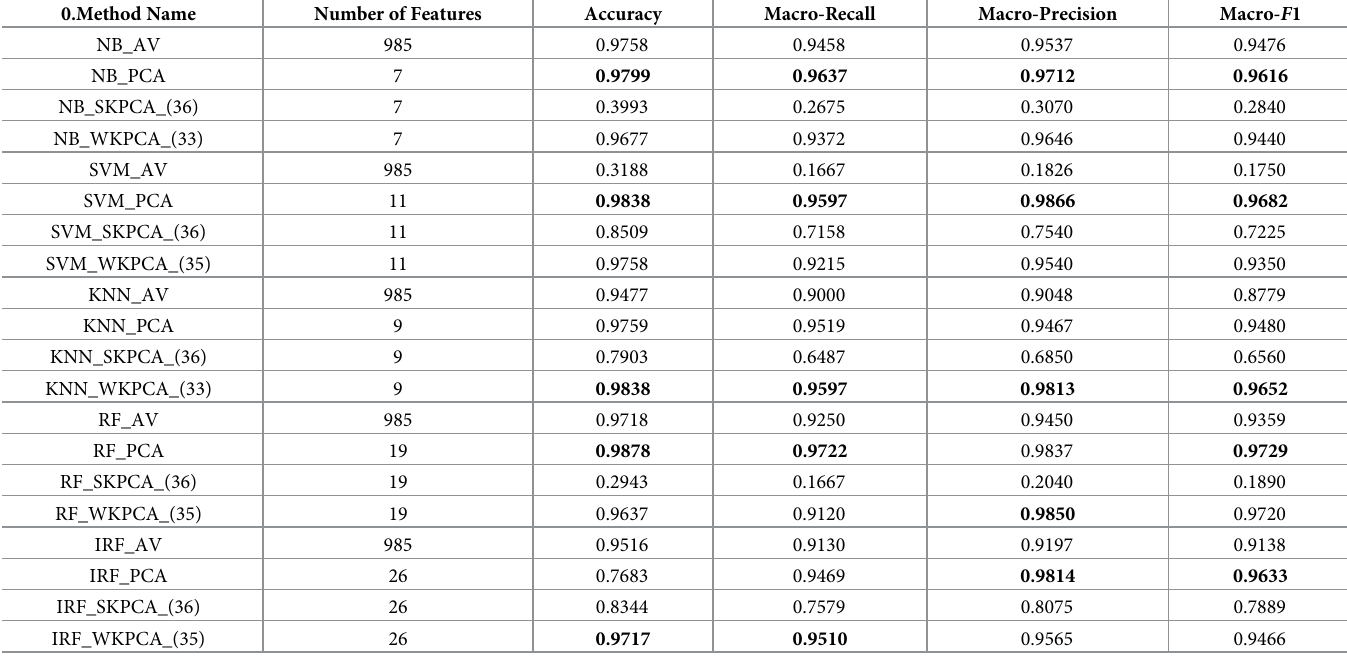
Table 6. Performance measurement comparisons of machine learning methods based on the Leukaemia data set after WKPCA dimension